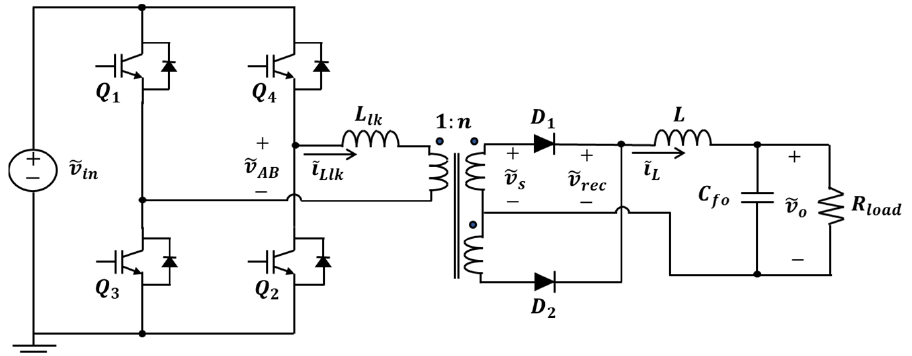
Figure 1. Schematic of the PSFB converter.